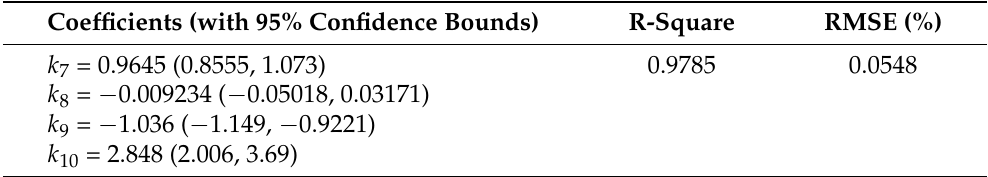
Table 8. Coefficients and performance of the instantaneous regenerative braking efficiency as a function of the deceleration